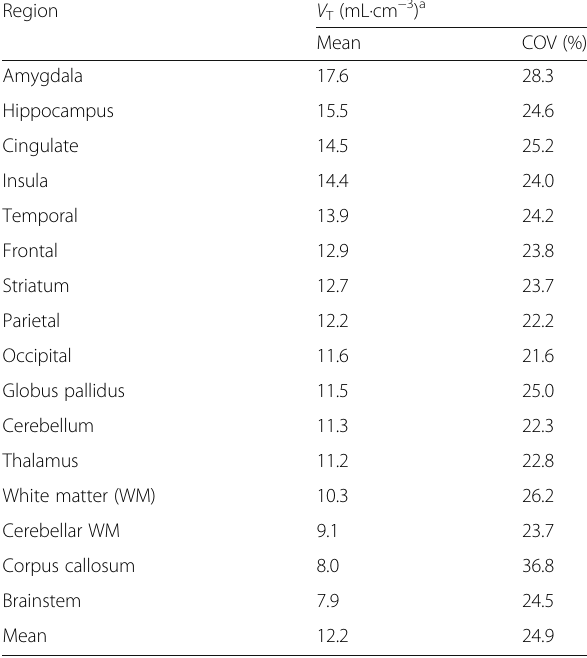
Table 2 Total distribution volume ( V T ) of brain regions after injection of [ 18